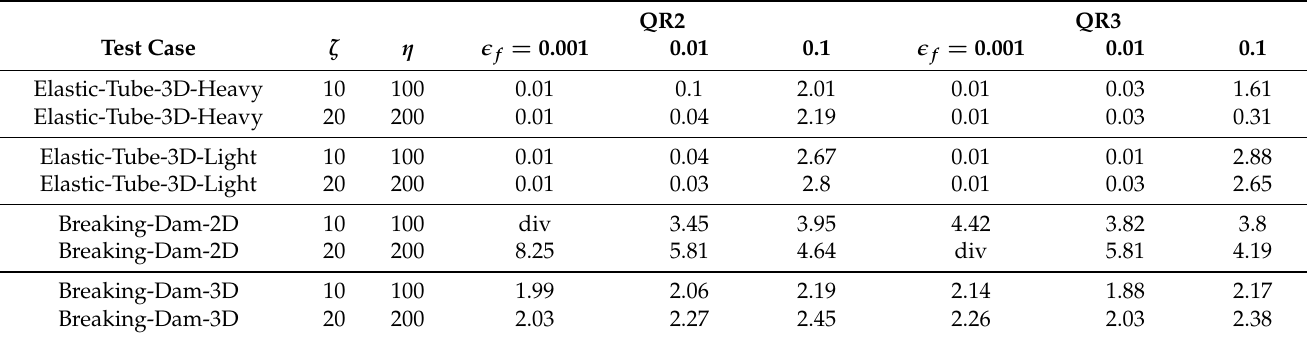
Table 4. Average number of columns deleted per time step for (i) pre-scaling update in every quasi- Newton iteration with the QR2 filter (column “QR2”), and (ii) the new pre-scaling weight monitoring approach with the new QR3 filter (column “QR3”). Three different filter limits (cid:101) f = 0.001, (cid:101) f = 0.01, and (cid:101) f = 0.1 are